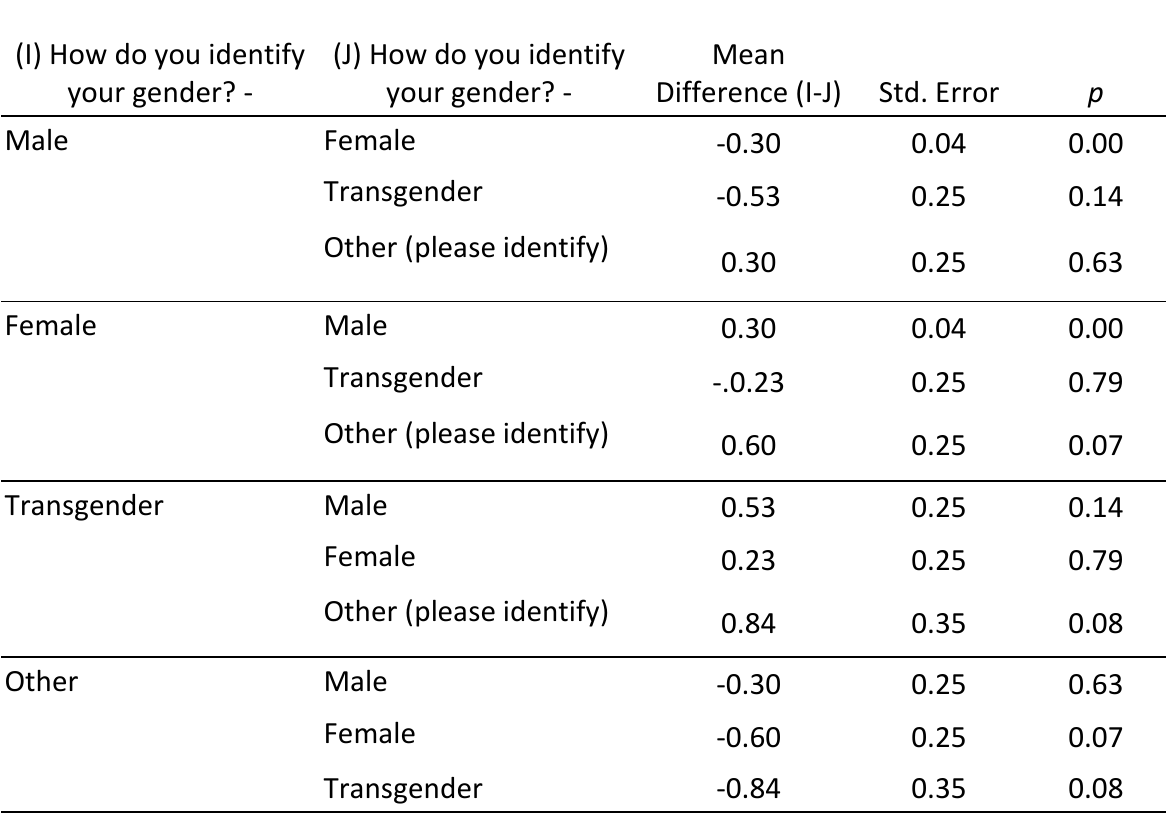
Post Hoc Multiple Comparisons